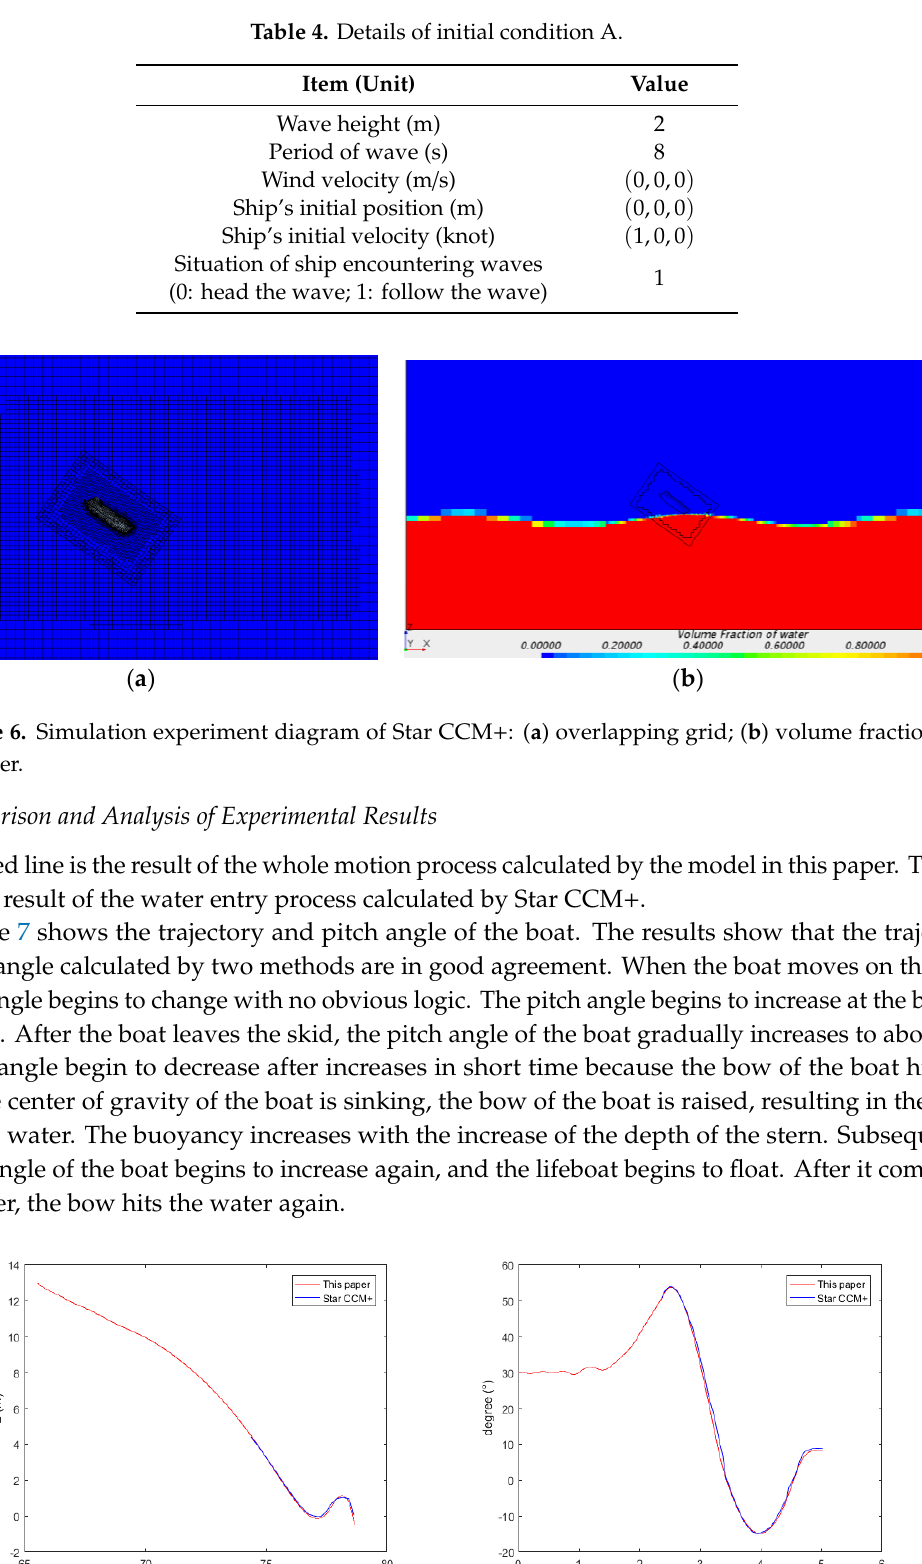
( b ) Figure 8. Acceleration of center of gravity of the lifeboat in the horizontal ( a ) and vertical ( b ) direction. Figure 9 shows the velocity of the center of gravity of the boat. The horizontal velocity of the boat gradually begins to increase at the skid, and remains the same in the air before entering the water; it begins to decrease due to the negative acceleration at the beginning of the water entry phase, and begins to increase when the boat floats up. The value of vertical acceleration is decreasing because the boat moves down the skid. The value of vertical acceleration decreases at the same rate because of g in the air before entering the water. Its value gradually increases until the sign is positive because of the slamming force and the buoyancy at the water entry phase; its sign becomes negative when the boat falls into the water again. The velocity values calculated by the two methods are in good agreement.